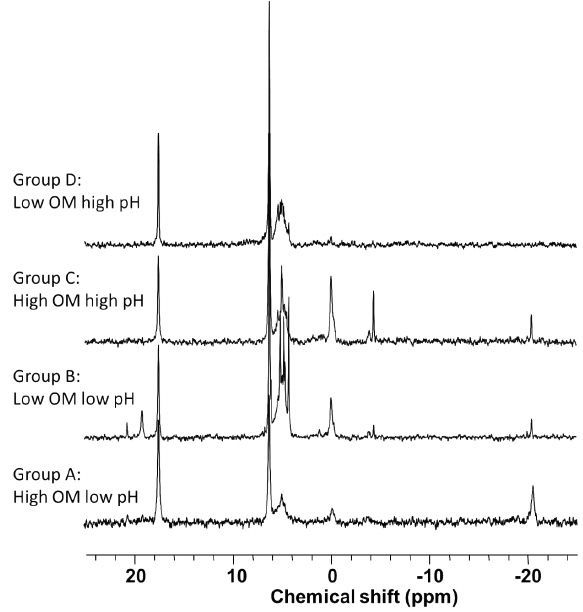
Figure 3. Solution 31 P NMR spectra of wetland soils representative of four wetland types identified in this study; see Figs. S1–S4 in the Supplement. Spectra acquired using an Avance III 500, Magnex 11 . 8tesla 54mm Bore, at pH > 13, using a simple zgig pulse pro- gram and calibrated 30 ◦ pulse angle. Spectra presented here, using 15Hz line broadening, scaled and referenced to internal standard methylenediphosphonic acid ( δ = 17 .